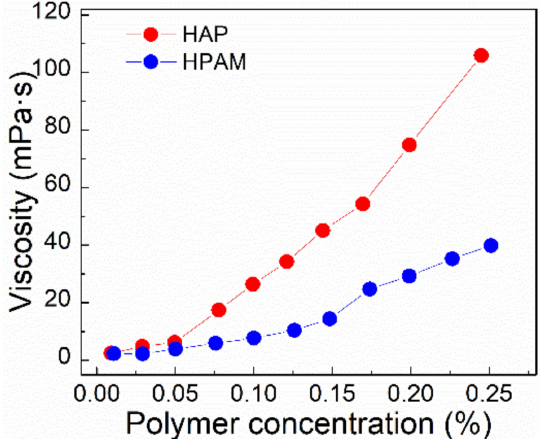
Figure 5. For HAP and HPAM, the viscosity as a function of concentration is displayed at 75 ◦ C. (Particle size of polymer powder, 40–120 mesh; salinity, 3.26 × 10 5 mg/L; shear rate, 7.34 s − 1